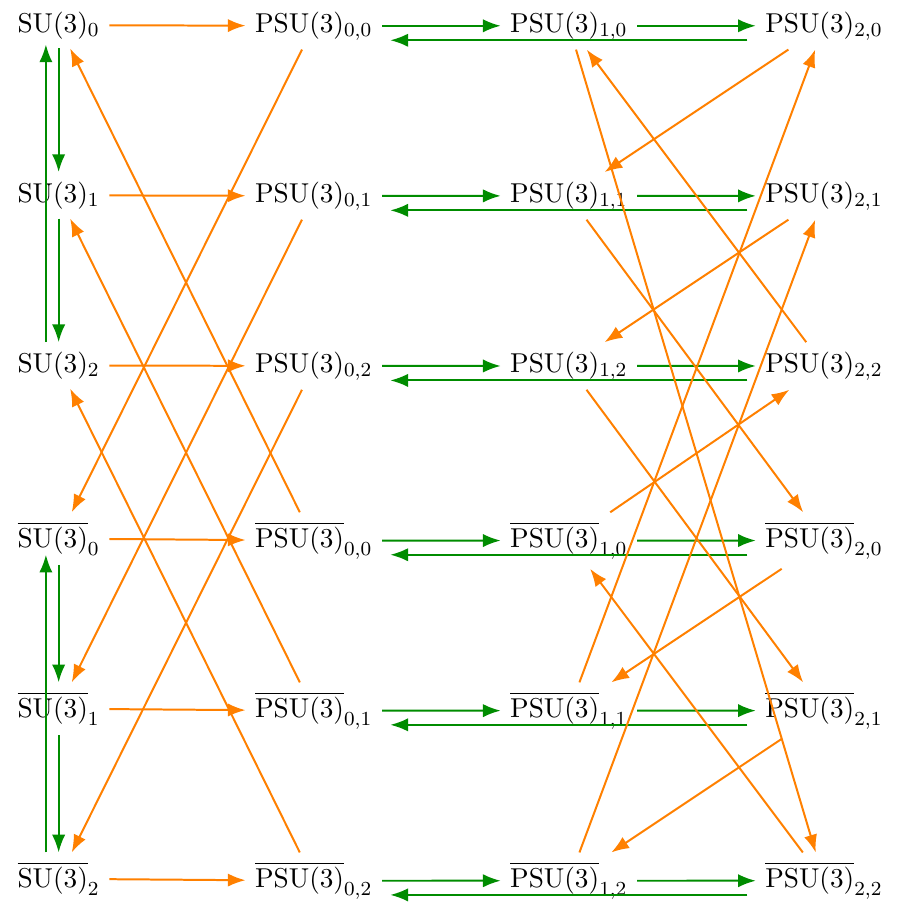
Figure 7 . Web of SL(2 , Z ) transformations for theories with gauge algebra su (3) . We have denoted the action of S in orange and the action of T in green, where S and T represent the usual modular